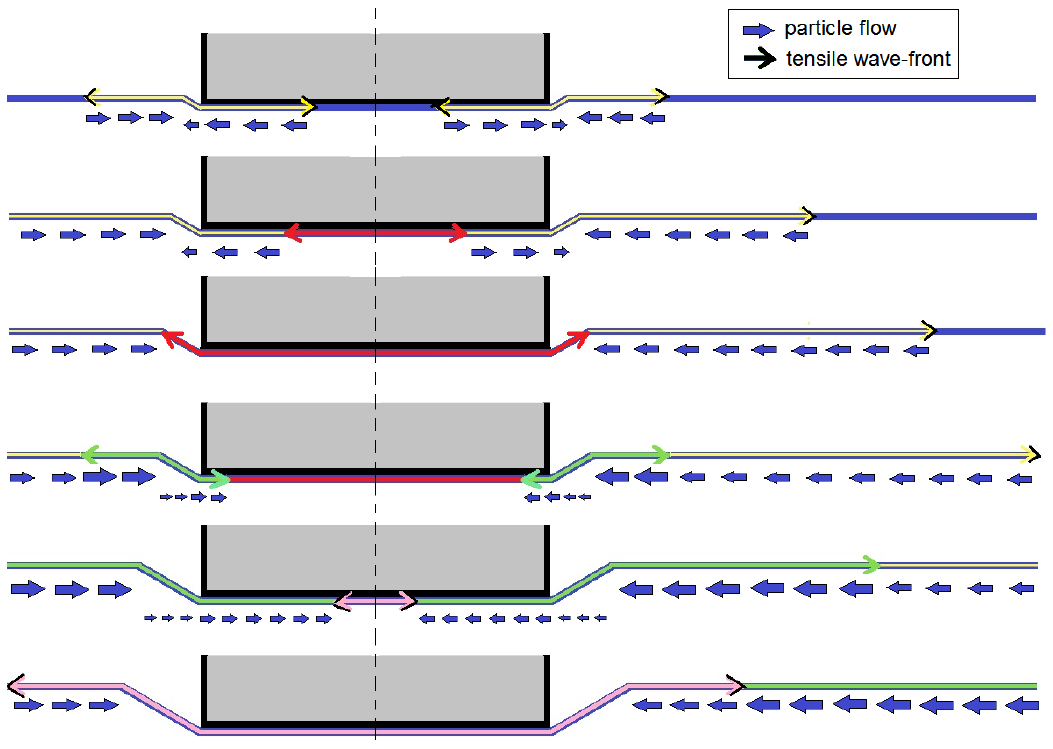
Figure 2. Evolution in terms of multiple frames (snapshots) over time of the colliding tension waves and subsequent reflections under a flat-faced projectile impacting a frictionless yarn. Multiple arrows also show the direction of particle flow.